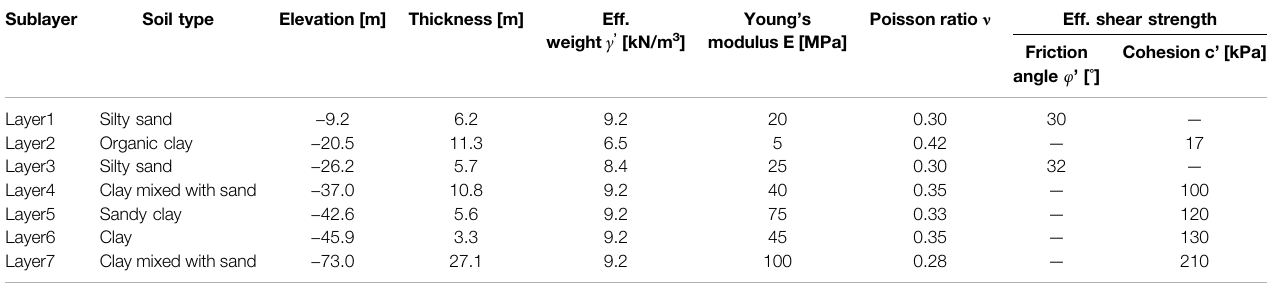
TABLE 1 | Material properties of each sublayer.